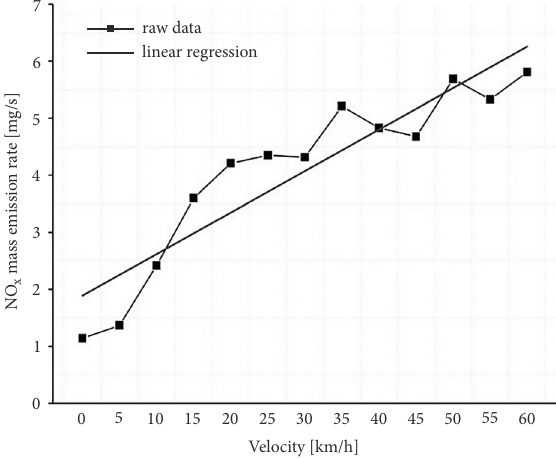
Figure 9. Velocity–emission rate regression curve of NO x